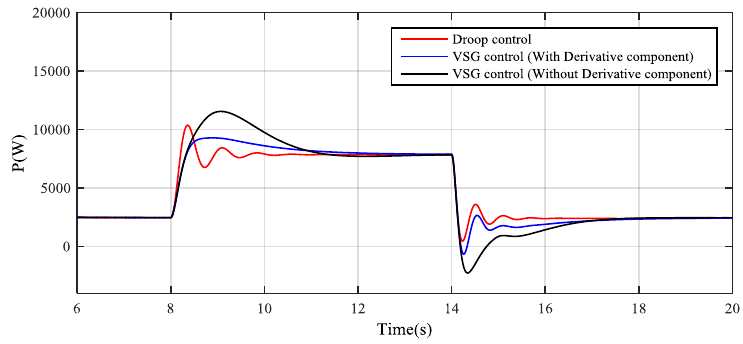
Figure 12. Active power of grid-forming converter.